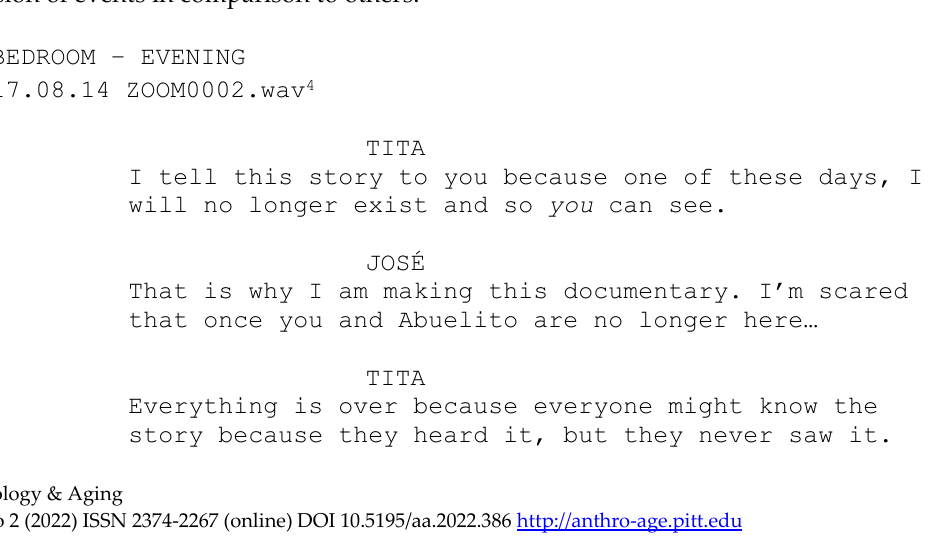
Figure 4: A page from the photographic printouts shared with my family during the interviews in 2014. They include photographs of Chucho, Uncle Julio and la Abuela Julia. Courtesy: Silvia Gonzalez, 2014 The process of setting up the cameras, recording the interviews, and allowing stories to emerge through the interviewing process was an incredibly rewarding experience. Every family member that agreed to share their stories was very excited to take part, and some of my uncles even admitted that they had meant to record Chucho’s stories but had never got around to it (Sherwood Gonzalez 2019a, 21). My great-aunt was able to clarify much of what mother had told me and could also add a lot of details that others did not know. Below is a conversation I had with my great-aunt Tita about the difference between her version of events in comparison to